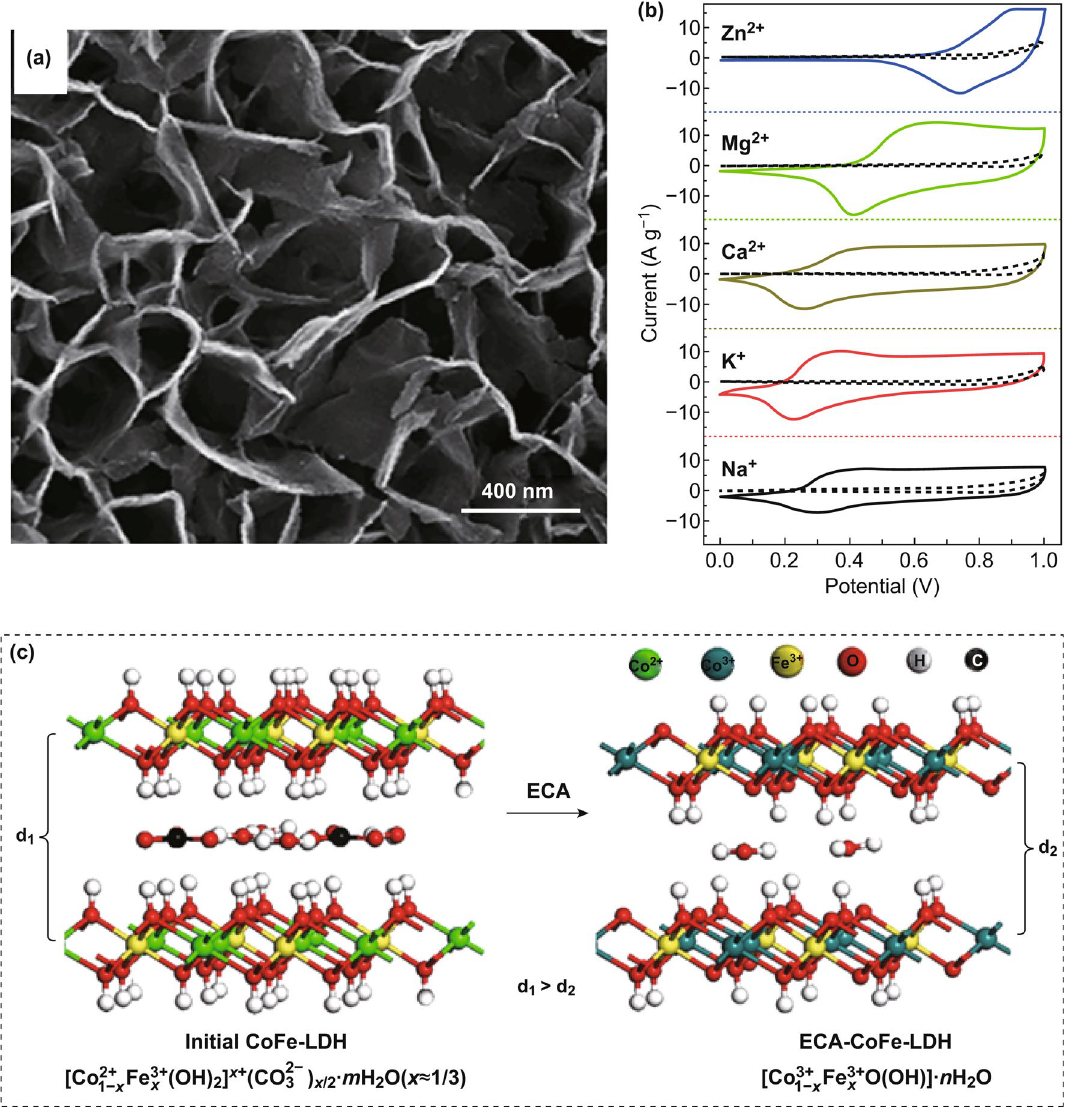
Fig. 28 a SEM image of CoFe layered double hydroxide (LDH) nanoplates. b CV curves and c galvanostatic charge–discharge profiles of CoFe‑ LDH in different aqueous solutions. d Evolution of the crystal structure and composition of CoFe‑LDH before and after electrochemical activa‑ tion. e Adsorption energies of various metal ions over H‑terminated (magenta) and O‑terminated (blue) LDH laminates. Reproduced from Ref. [272] with